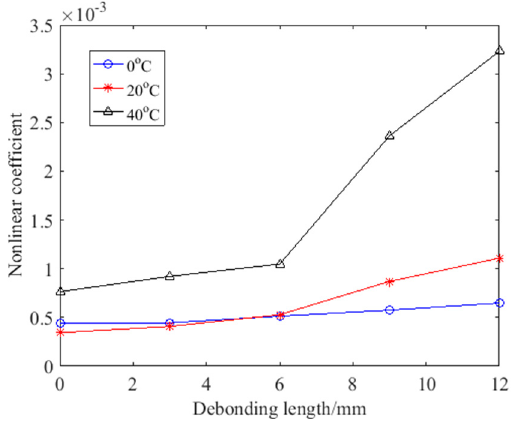
Figure 13. The variation curves of the nonlinear coefficient under different temperatures.